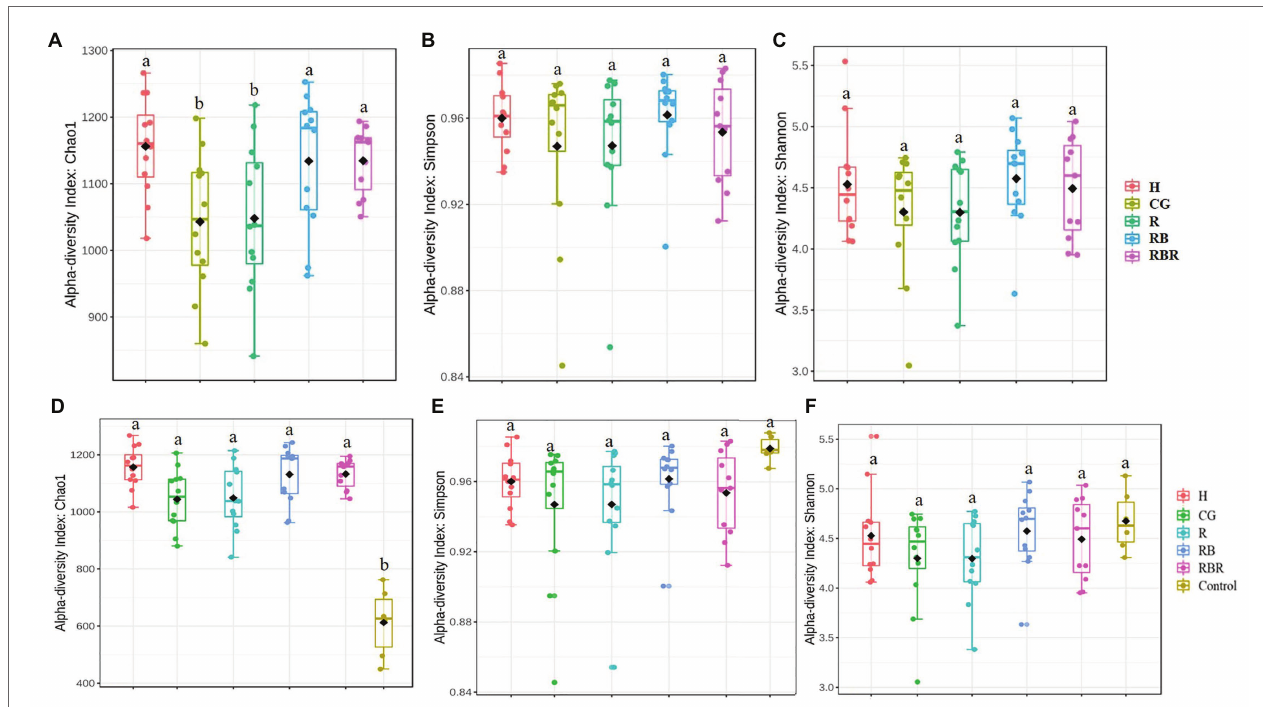
FIGURE 2 | Alpha diversity of bacterial communities in runoff water from different pasture management treatments. Treatments included: hayed (H), continuously grazed (CG), rotationally grazed (R), rotationally grazed with a buffer strip (RB), and rotationally grazed with a fenced riparian buffer (RBR). Illustrates results from only pasture management included three indices of Chao1 (A) , Simpson (B) and Shannon (C) . The factor includes non-agricultural samples (control), Chao1 (D) , Simpson (E) , and Shannon (F)